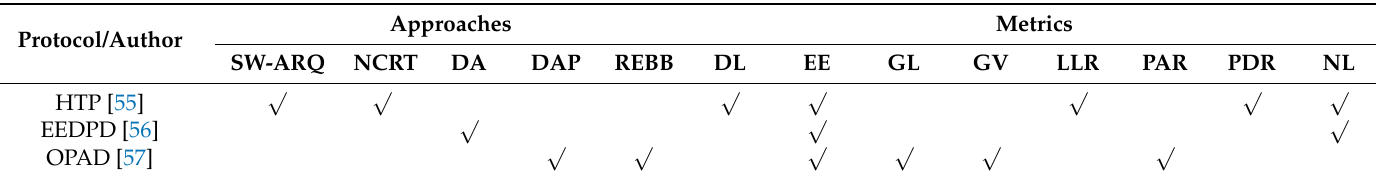
Table 17. Comparative assessment of energy efficient techniques at application